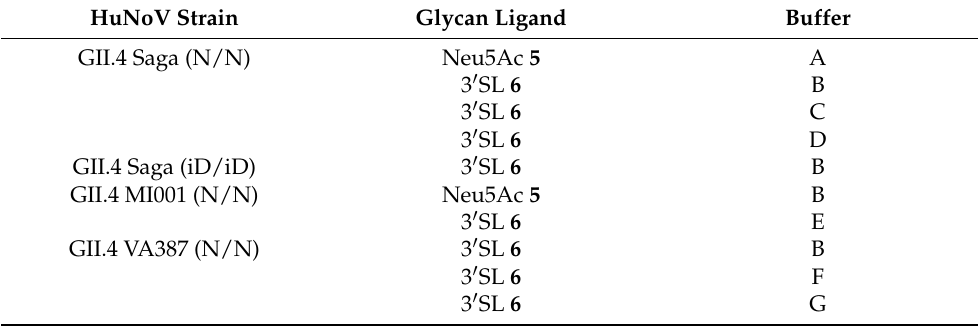
N/N P-domains, 100 µ M for Saga iD/iD P-domains, 80–180 µ M for MI001, and 170 µ M for VA387. Carbohydrate concentrations were 5–16 mM. NMR spectra were acquired at 298